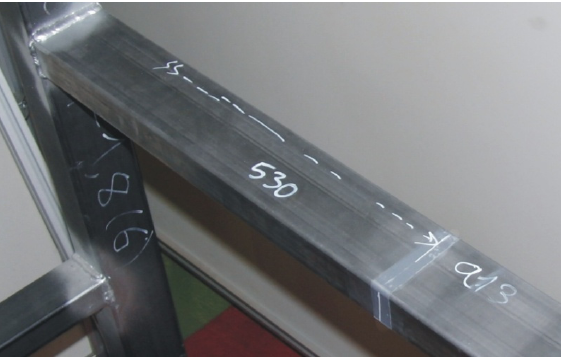
Figure 9. Detail of the region adjacent to the a13 measurement section.